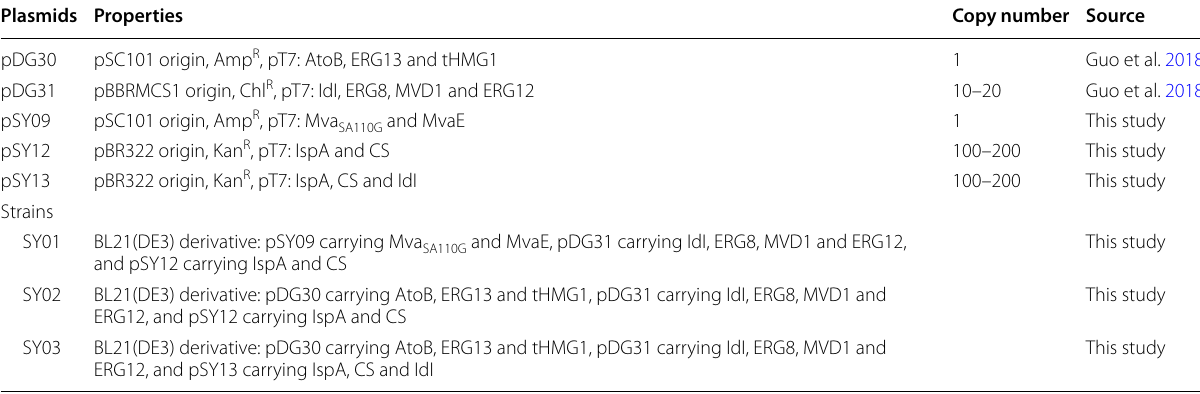
Table 2 Plasmids and strains used in this study Plasmids